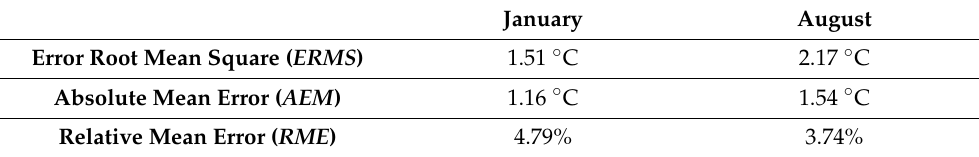
Table 22. Errors between estimated and measured temperature.